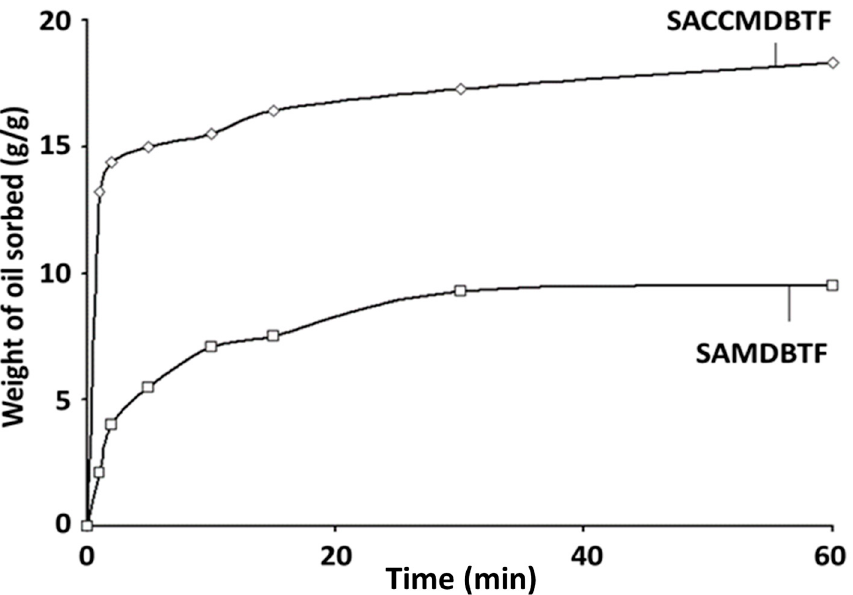
Figure 5. Quantity of used car engine oil sorbed (g oil g –1 fiber) with respect to time (min) by SAC- CMDBTF and